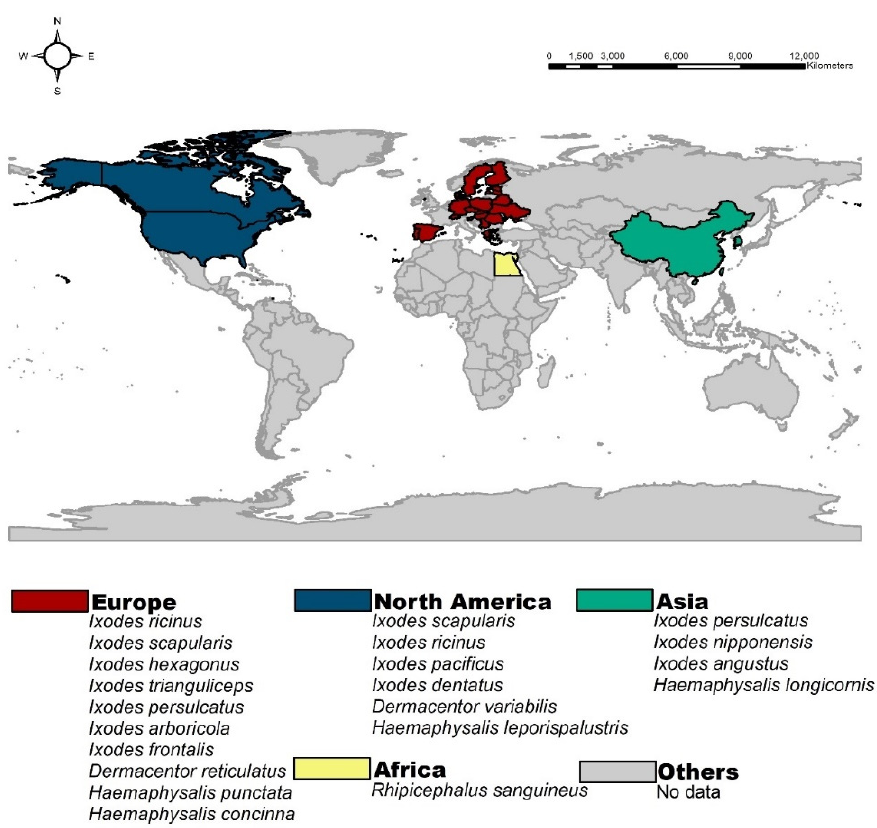
Figure 7. Geographical distribution of tick species carrying Borrelia burgdorferi across the world.